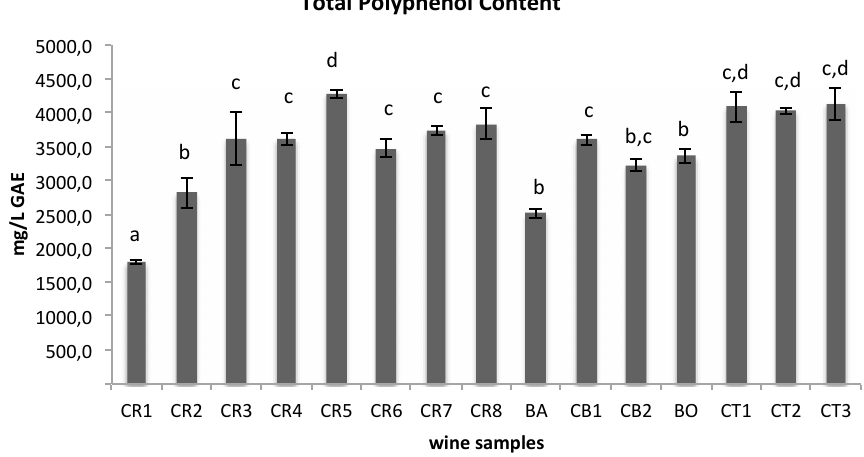
Figure 1. Total polyphenol content of the 15 wine samples by Folin-Ciocalteau’s assay. Data (mg/L GAE) are expressed as the mean ± SD ( n = 3); different letters indicate statistically significant differences ( p < 0.05) between samples.